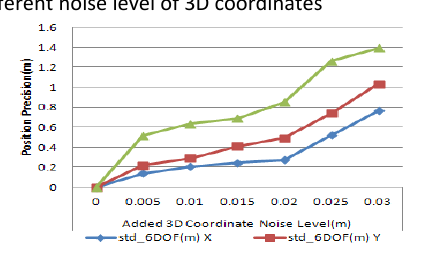
Figure 12. Variation of position precision at different noise level of 3D coordinates